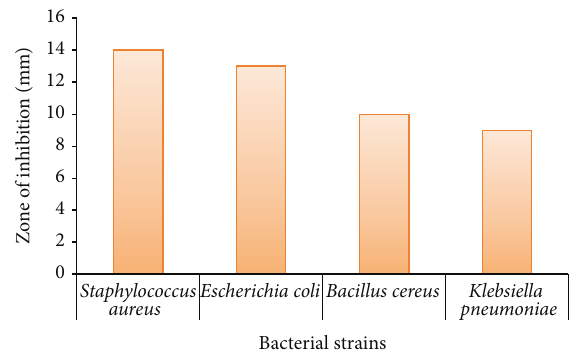
Figure 5: Comparison of effectiveness of Ni nanoparticles against different bacterial